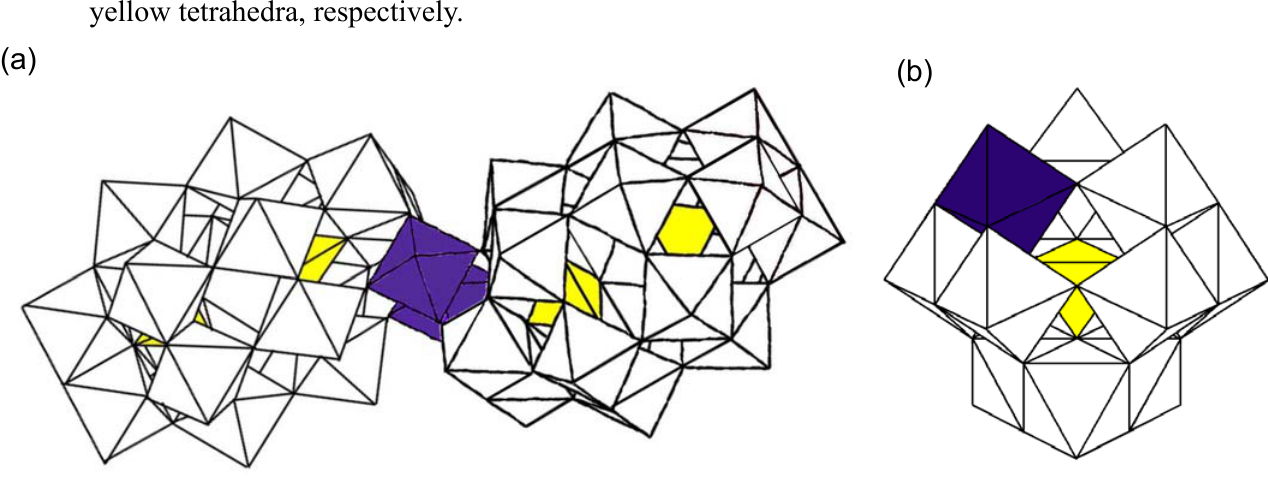
groups are represented by white octahedra and 4